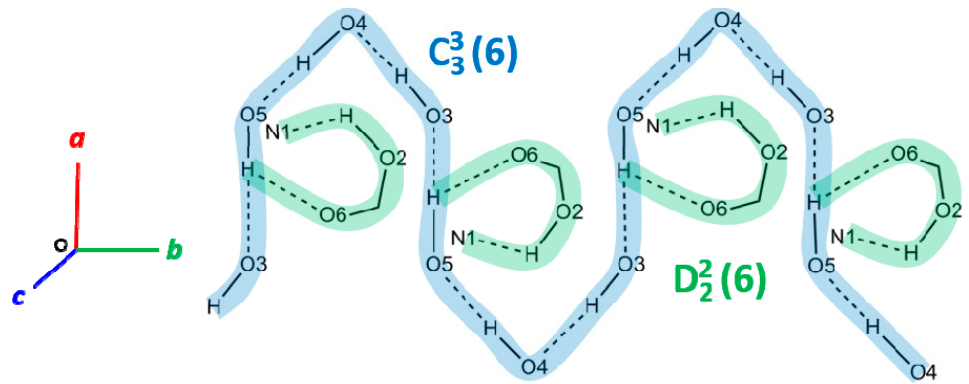
Figure 4. Hydrogen bonding pattern in crystal structure of N -(1-deoxy- α - D -tagatopyranos-1-yl)- N -methylaniline.